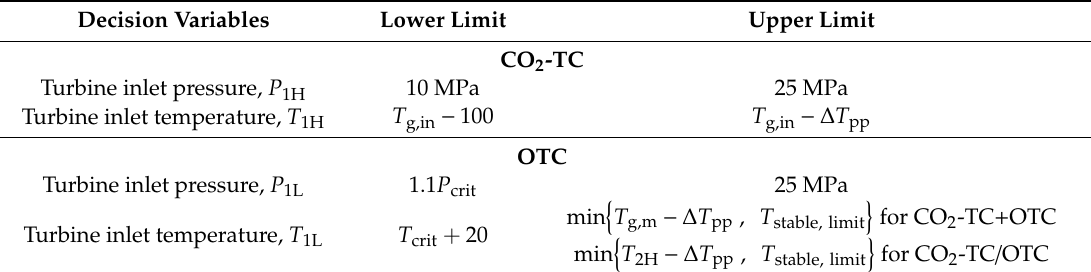
Table 3. Decision variables and the lower and upper